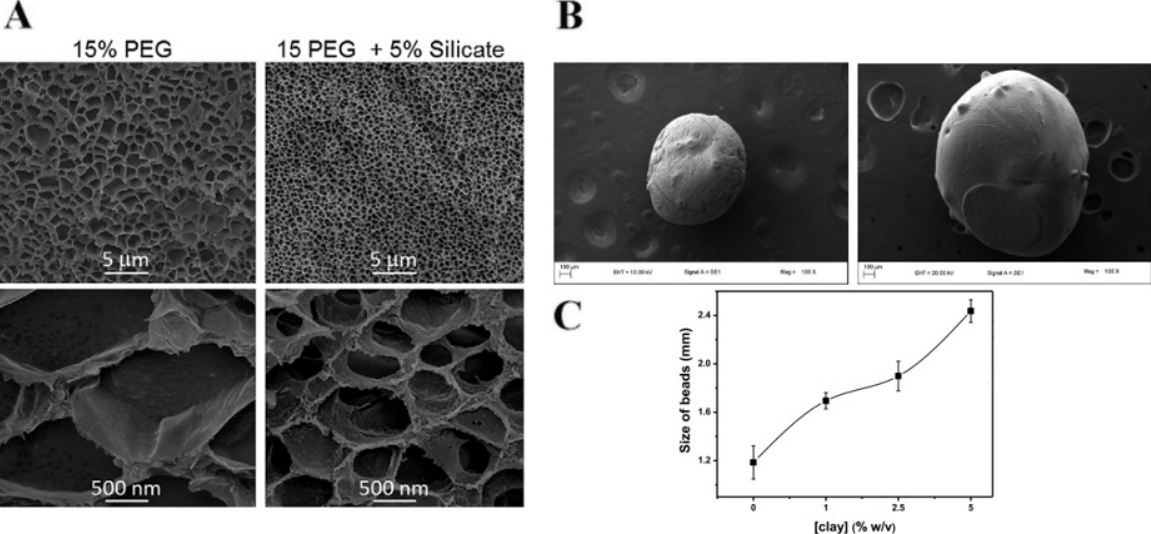
Figure 14. ( A ) Representative SEM images of hydrogel microstructures showing highly porous structures with interconnected pores. The addition of silicate nanoparticles decreases the pore size of hydrogel networks. (Adapted with permission from [65]. Copyright 2015, Elsevier). ( B ) SEM image of the pristine alginate hydrogel bead (left) and nanocomposite bead prepared with 1% clay (right). ( C ) Relation between the size of alginate hydrogel nanocomposite beads and clay concentration. (Adapted with permission from [50]. Copyright 2018, Elsevier).